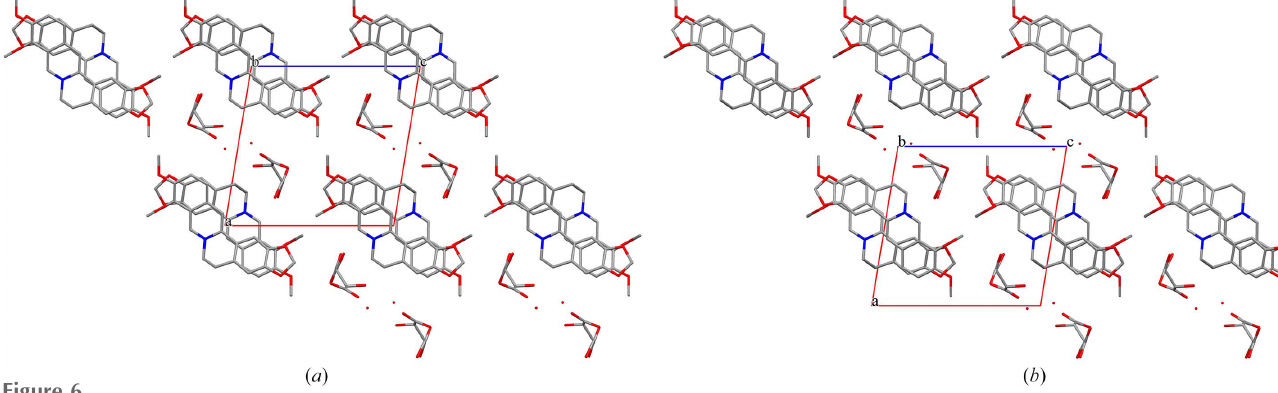
hydrogen bonds, O —H (cid:6) (cid:6) (cid:6) O , O —H (cid:6) (cid:6) (cid:6) O and O — 7 11 11 5 11 to form a chain-like structure. The connection is H (cid:6) (cid:6) (cid:6) O 7 further strengthened via the hydrogen bond O —H (cid:6) (cid:6) (cid:6) O to 9 6 form a 12-membered ring-like structure. (cid:9) – (cid:9) interactions in 1BER-1 l TA-1W and 1BER-1 d TA-1W (Fig. 5) exist between